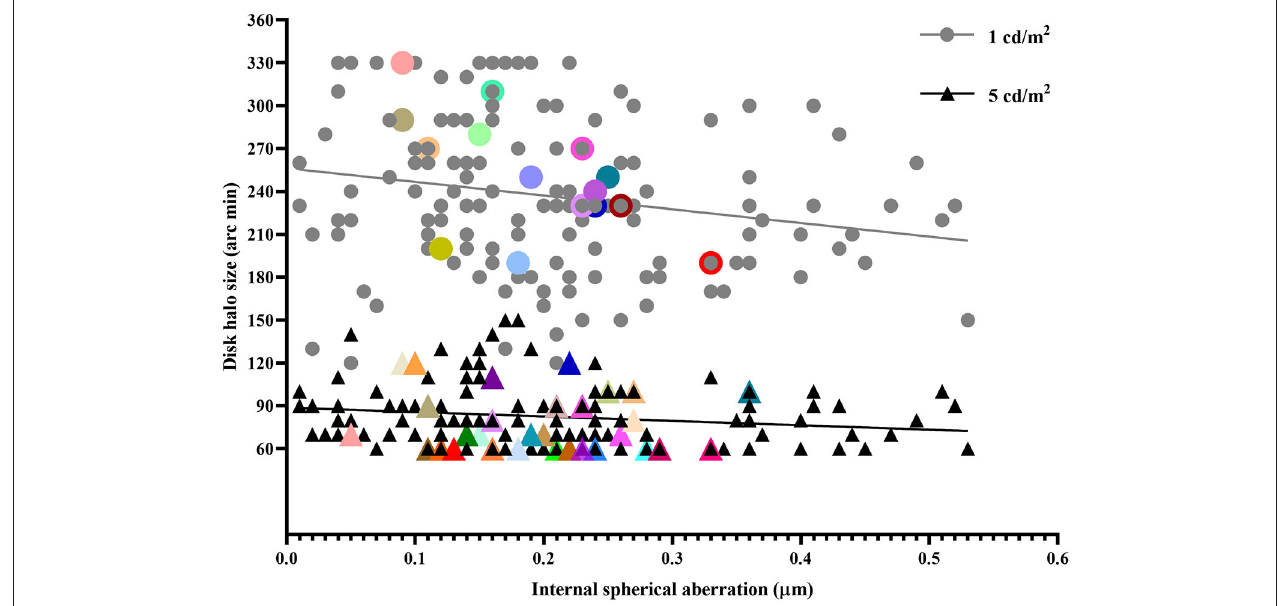
FIGURE 2 | Disk halo size as a function of internal spherical aberration in patients with myopia and myopic astigmatism ( n = 150). The overlapped dots were characterized by bigger size and different